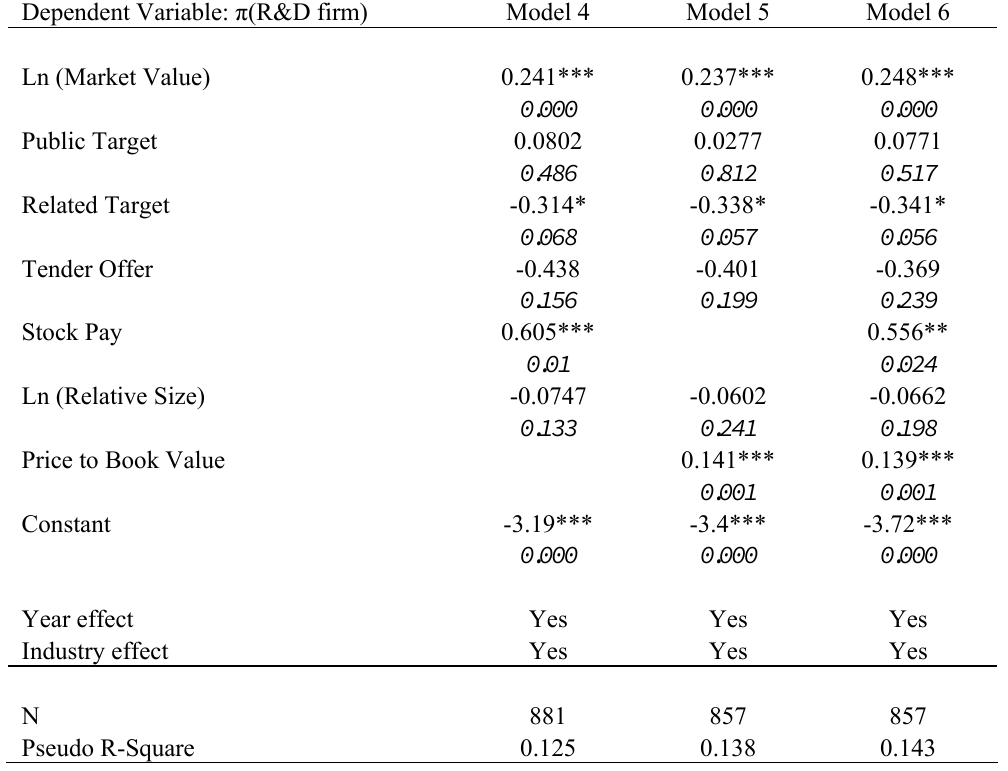
Table 5. Differentiating Characteristics of R&D